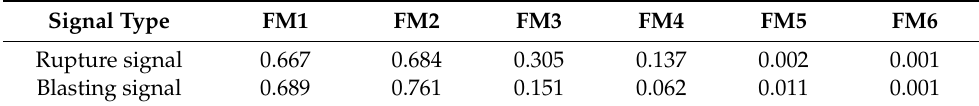
Figure 7. LMD decomposition and frequency spectrum of typical microseismic signals in mines. ( a ) PF component of coal − and − rock − mass − fracture signal ( b ) PF component frequency spectrum of Table 1. Correlation coefficient of different PF components. coal − and − rock − mass − fracture signal ( c ) PF component of blasting-vibration signal ( d ) PF compo- nent frequency spectrum of blasting − vibration signal.